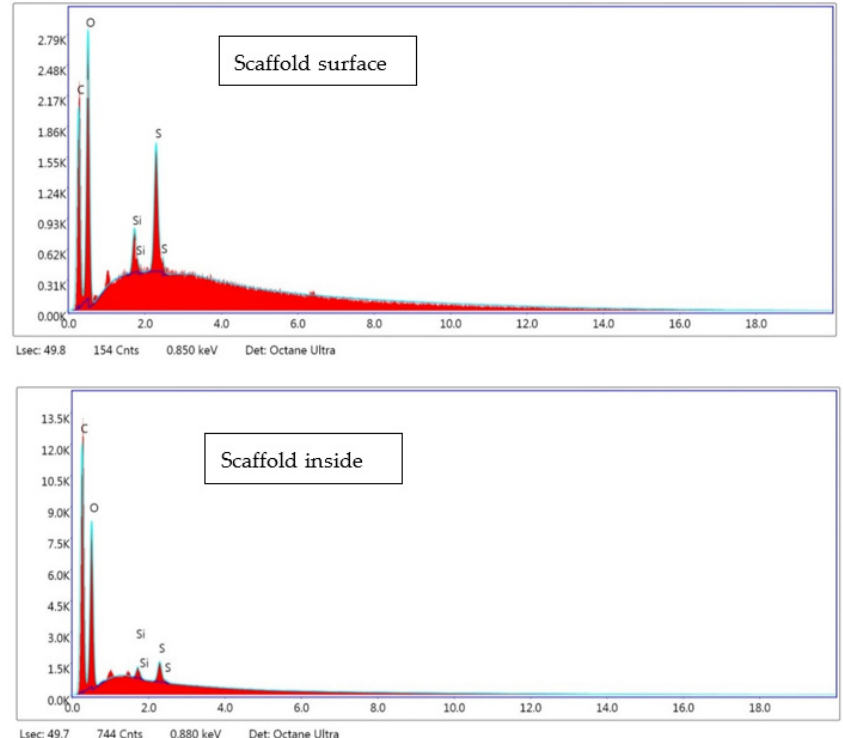
Figure 3. EDX spectra corresponding to composition on the surface and inside the scaffold (experi- ment 3).